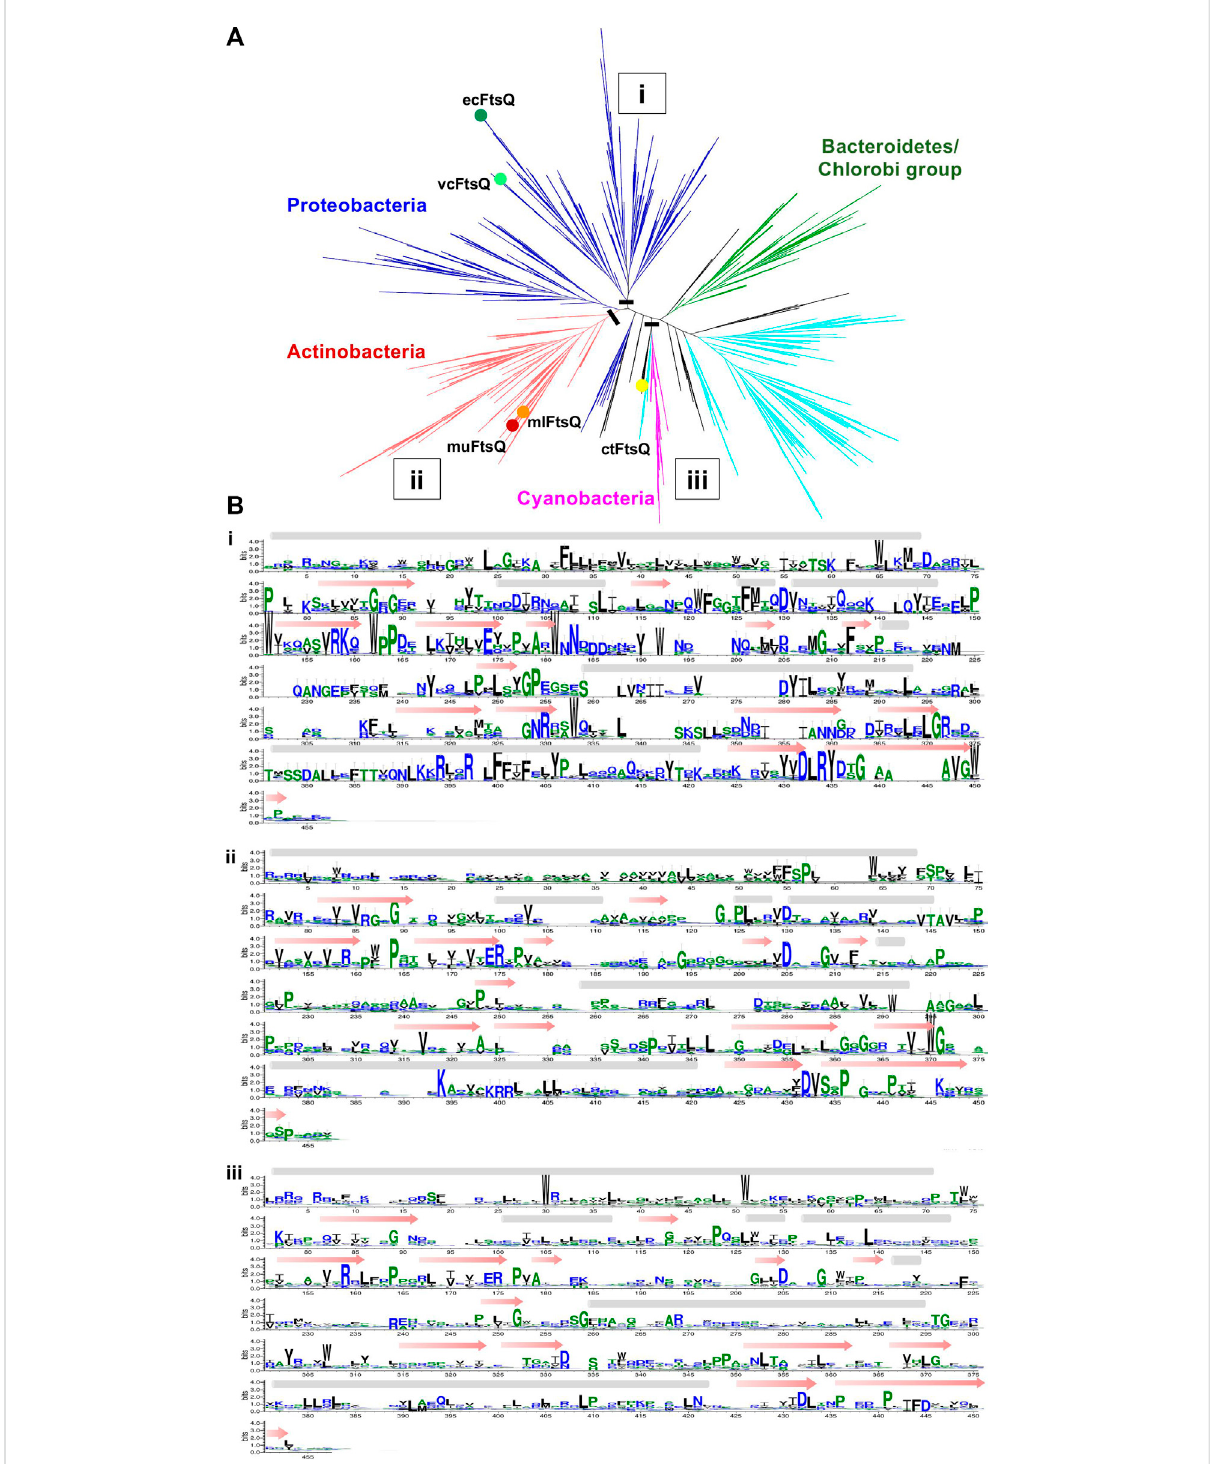
FIGURE 4 (A) Unrooted cladogram represents the phylogenetic clustering of FtsQ from diverse bacterial taxa. The dominant phylum proteobacteria, Firmicutes, actinobacteria, Bacteroidetes/chlorobi group, and cyanobacteria were colored blue, cyan, red, green, and pink respectively. The phyla withlessthan(0.5%)representationareallcoloredblack.NodesforthevcFtsQ,muFtsQ,mlFtsQ,andctFtsQarehighlightedintheirrespectivephyla. Eachnodeshowsadivergenceof10%inthephylogenetictree. (B) Sequencelogosrepresentativeofthemultiplealignmentsbuiltfromdifferent phylums/clades in which the FtsQ homologs are present in fi gure. A black bar shows the location at which tree is